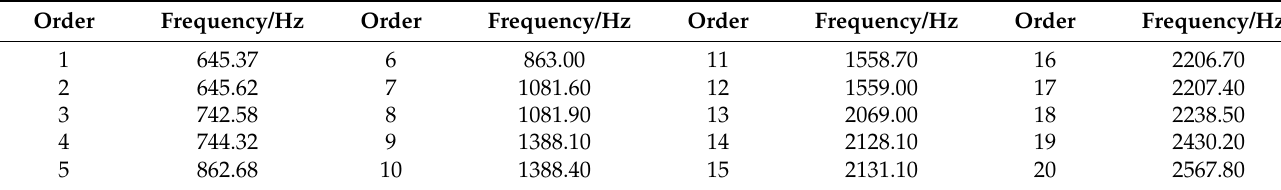
Table 2. The first 20 order natural frequencies of L-shaped flexible ring gear.